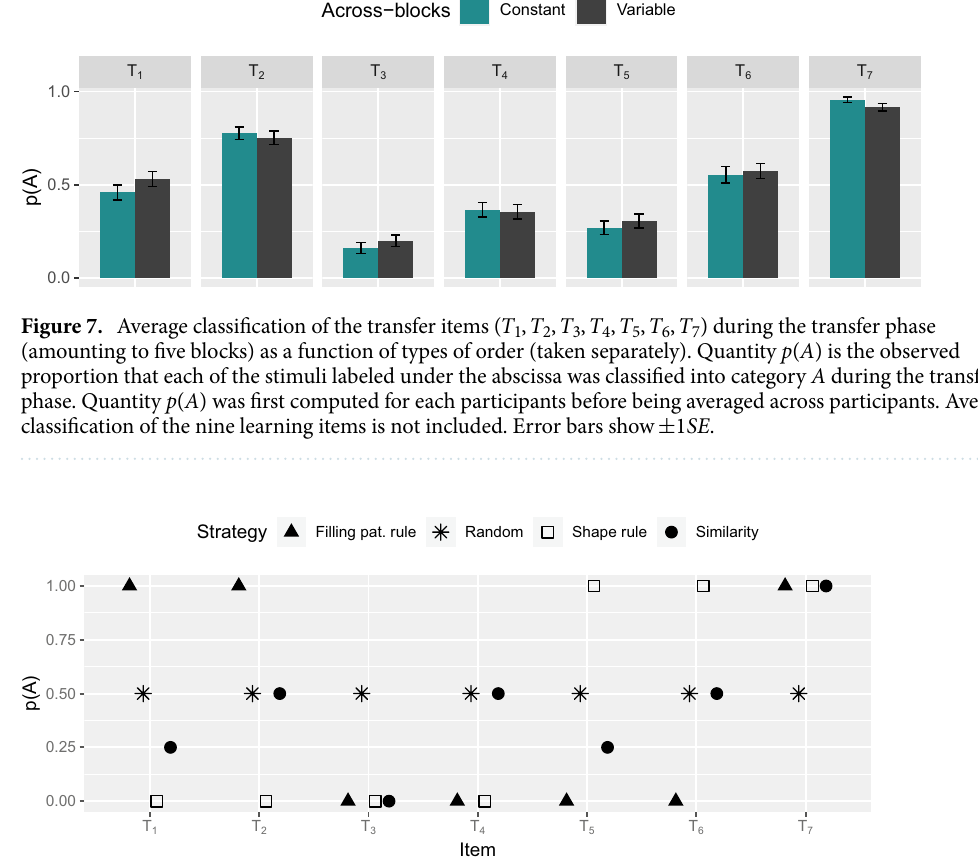
Figure 8. Putative classification of the transfer items ( T 1 , T 2 , T 3 , T 4 , T 5 , T 6 , T 7 ) as a function of the applied strategy (rule-based strategy using Filling pattern, rule-based strategy using Shape, similarity-based strategy, and random strategy). Quantity p ( A ) is the putative probability for a chosen strategy to classify into category A each of the stimuli labeled under the